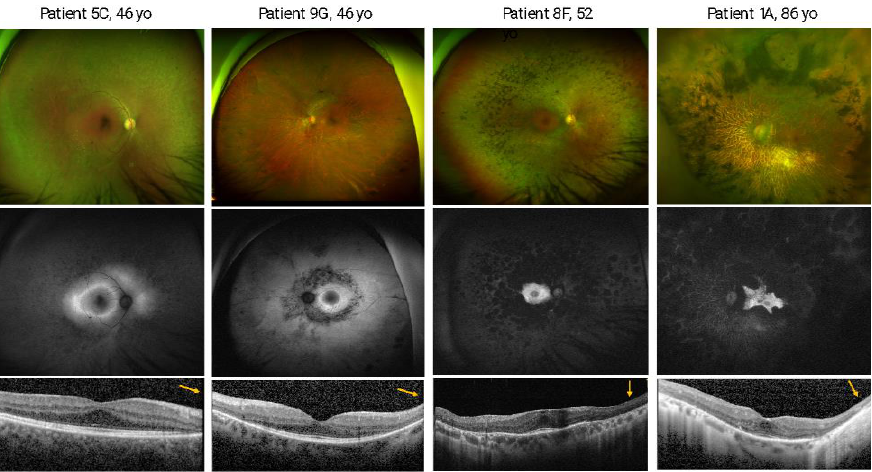
Figure 2. Retinal phenotype spectrum of the study population. For patients 5, 9, 8, and 1, ultra-widefield (UWF) color fundus photography (top), UWF-fundus autofluorescence (middle) and spectral domain optical coherence tomography (SD-OCT, bottom) images are depicted. Only 1 eye is shown in all cases due to high inter-eye symmetry. The cases shown from left to right reflect increasing disease severity in the different imaging modalities. The orange arrows indicate the SD-OCT b-scan direction.